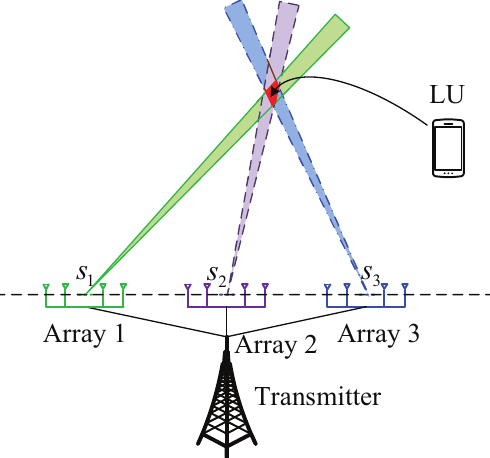
Figure 2. The principle of secure and precise wireless transmission for three antenna arrays with the help of AN-aided DM